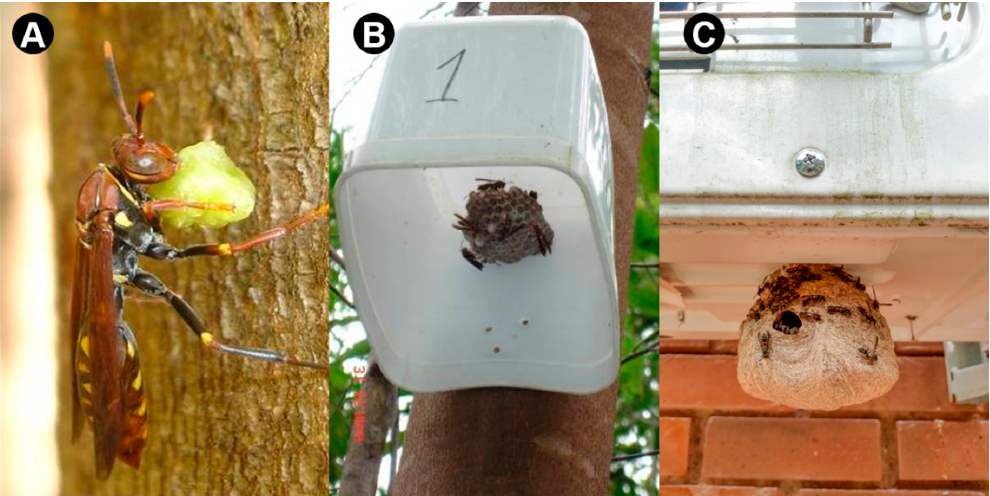
Figure 1. ( A ) Social wasp holding a fragmented caterpillar prey in a small farm environment. ( B